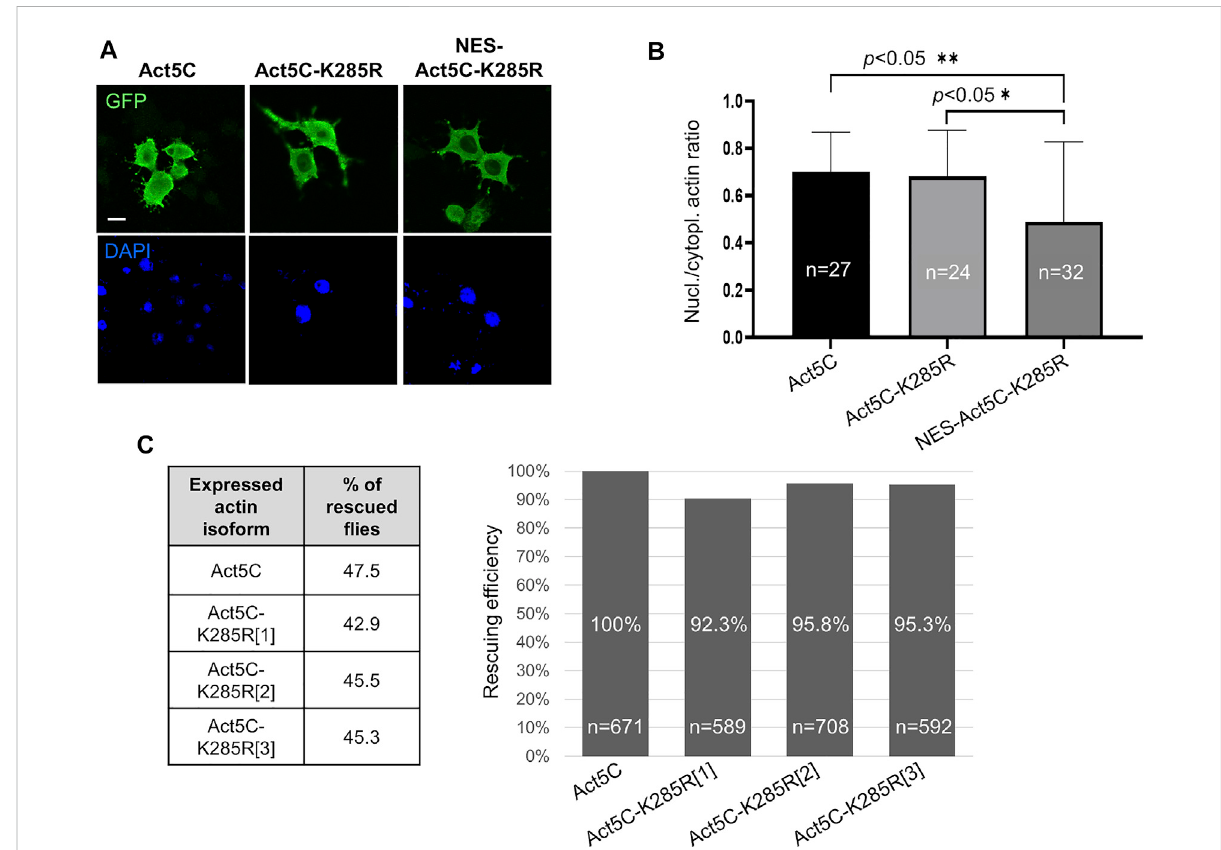
FIGURE 3 SumoylationatK285doesnotcontributesigni fi cantly tonuclearretentionofactinin Drosophila . (A) Immunostainingwithanti-GFPantibodyof Drosophila S2R + cells expressing GFP-tagged wild type (Act5C), non-sumoylatable (Act5c-K285R) and NES-tagged + non-sumoylatable (NES- Act5C-K285R)actinproteins(green).NucleiarevisualizedbyDAPIstaining(blue).Scalebar,50 μ m. (B) Quanti fi cationofimmunostainingin (A) . “ n ” is the number of cells examined. Unpaired t- test was used for statistical analysis. p -values: ** = 0.0048 and * = 0.0155. Error bars represent standard deviation. (C) Bar chart presentation of the data of the rescue experiments with the non-sumoylatable form of actin. Three independent transgenic Drosophila lines which express Act5C-K285R under the endogenous Act5C promoter (Act5C-K285R[1-3]) have been used in three parallel experiments. The percentage ratio of the fl ies rescued with wild type actin (Act5C) was considered as 100% rescue. The percentage of rescuing ef fi ciency was calculated by comparing the percentage ratio of the rescued category obtained with the Act5C-K285R forms to the 100% rescue. “ n ” is the total number of male offspring in the given rescue